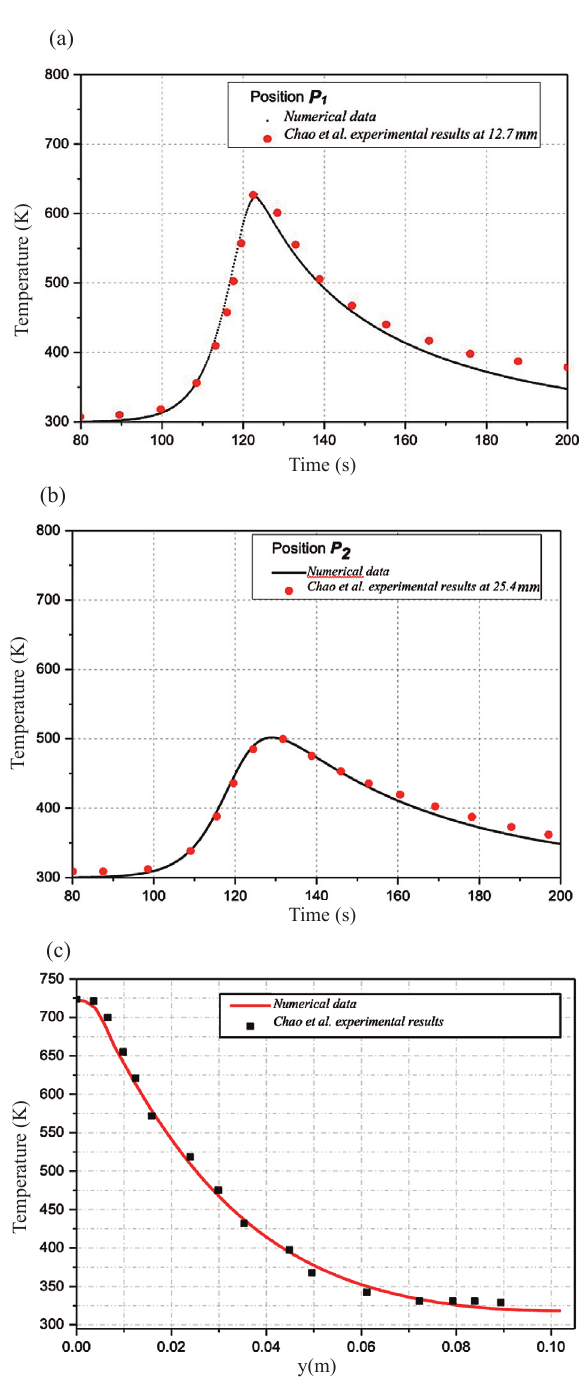
Fig. 3. Comparison of the numerical thermal histories obtained by Chao et al. [15]: the experimental results at two positions of the workpiece (a) P (L/2, 12.7, H/4) and (b) P (L/2, 25.4, H/4), as well as along the (y) line that is perpendicular to the weld line